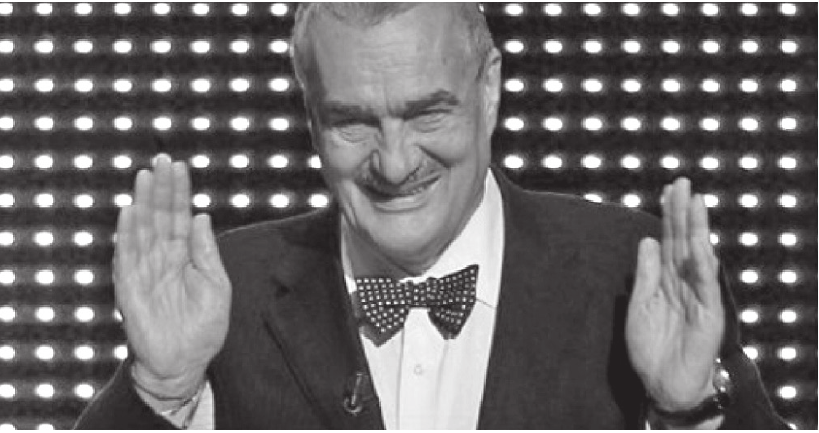
Fig. 3. Karel Schwarzenberg, Lidovky.cz , 22. 1.